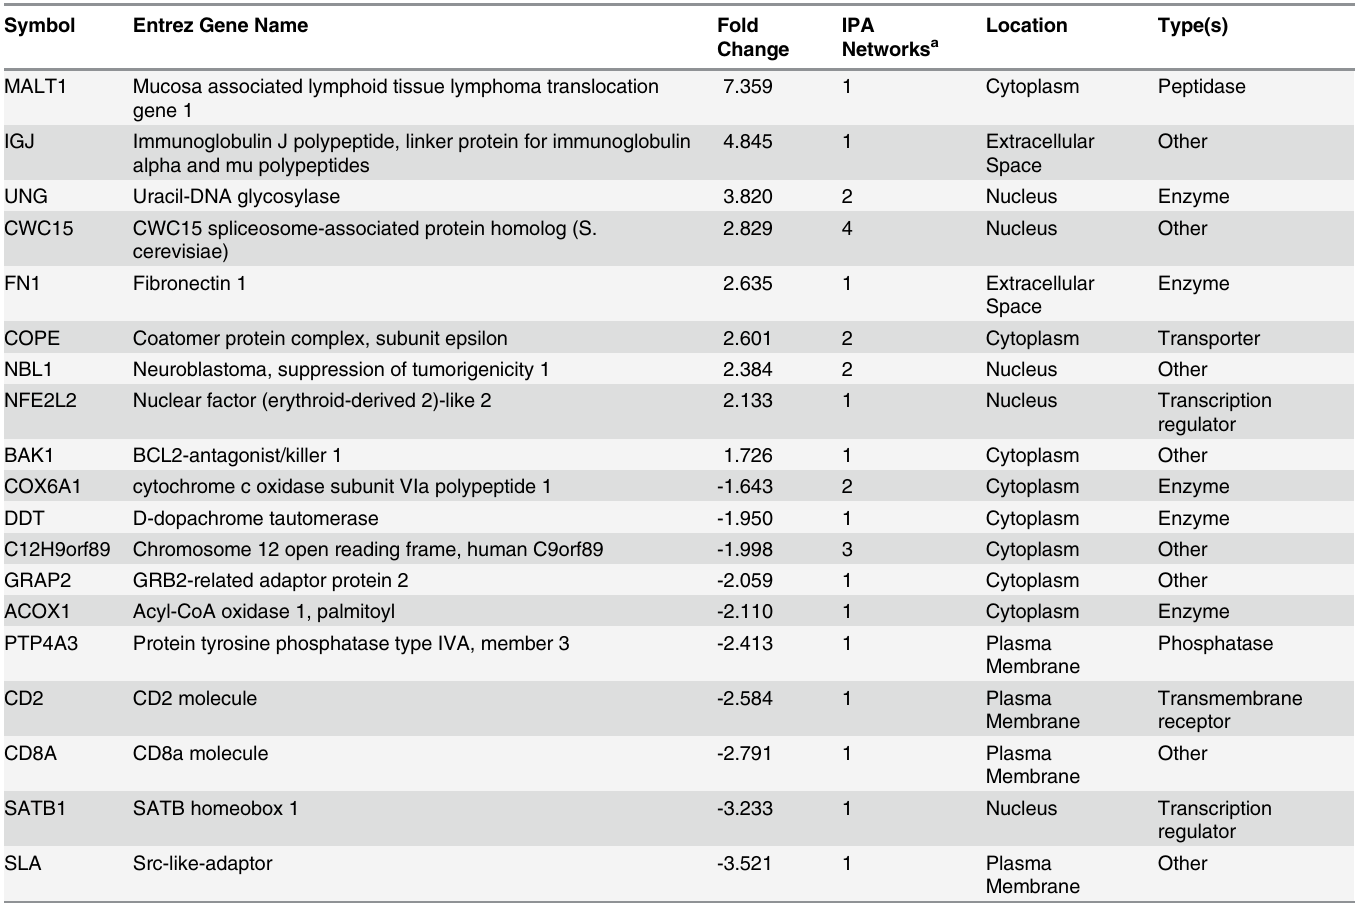
Table 4. Most differentially regulated transcripts in thymus as identified by IPA microarray